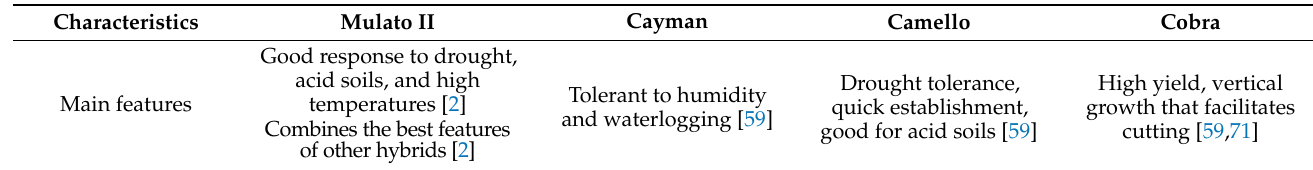
Table 1. Potential competitors for new interspecific hybrids of Urochloa . Characteristics